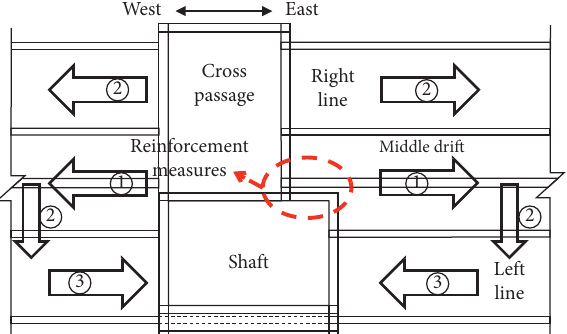
Figure 4: Section of